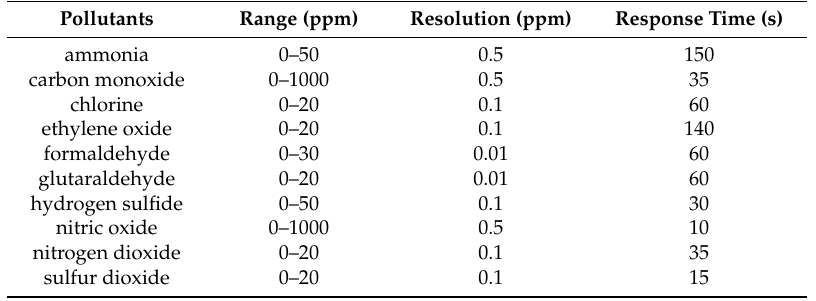
Table 1. Electrochemical sensors by Environmental Sensors Co. for measurement toxic compounds in